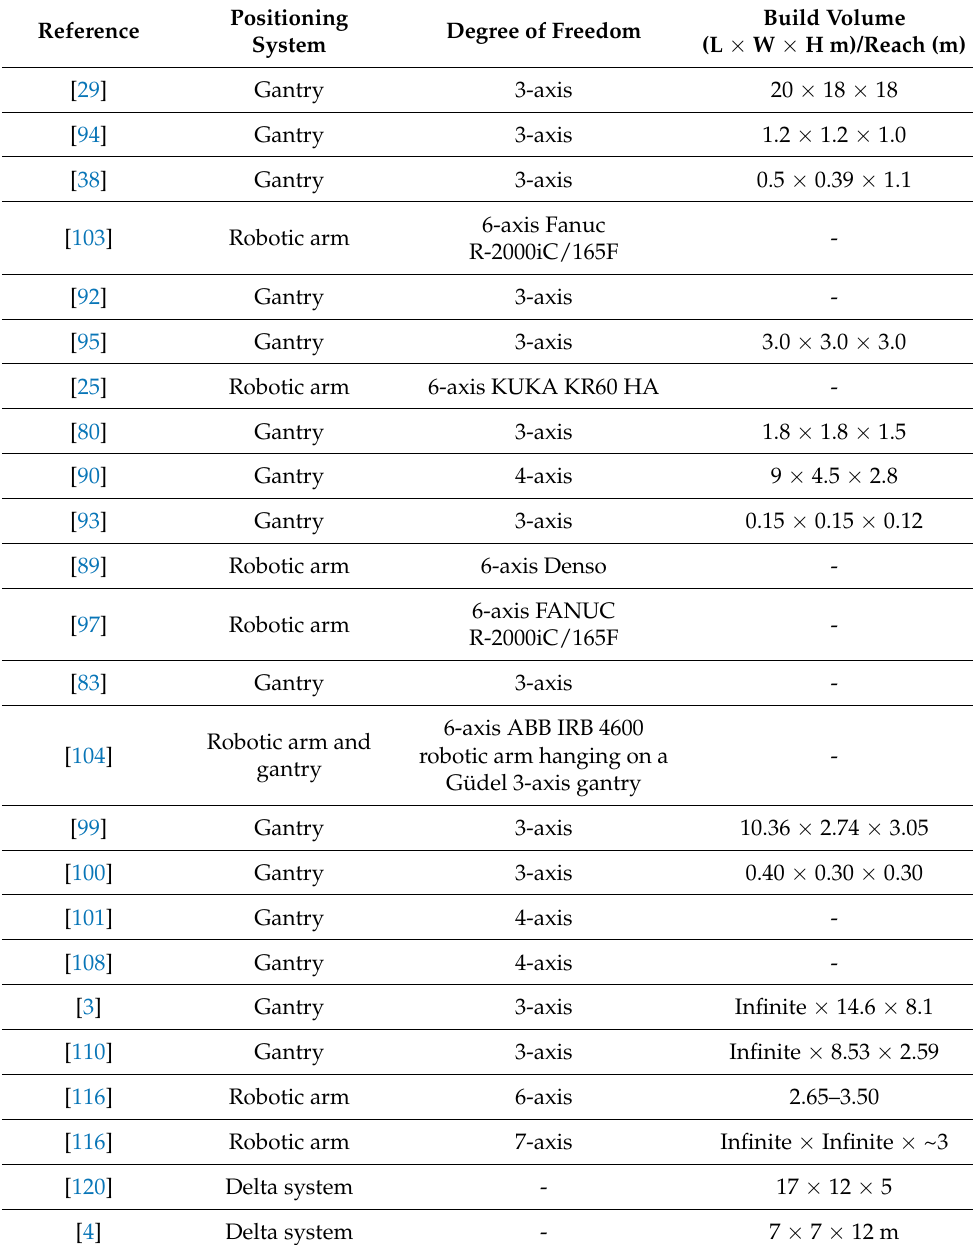
Table 7. Some examples of 3D concrete printers in terms of position system, build volume, horizontal printing speed, layer height and layer